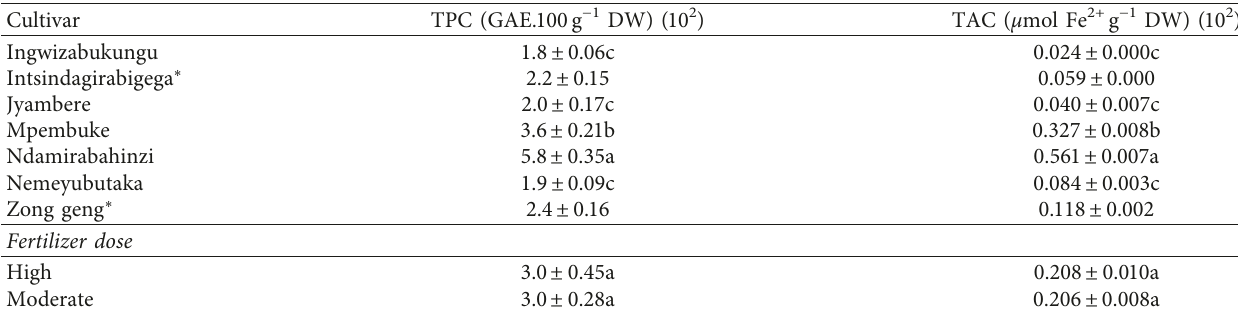
only for moderate fertilizer dose Table 4: Total phenolic content (TPC) and total antioxidant capacity (TAC) in Rwandan rice cultivars. Cultivar